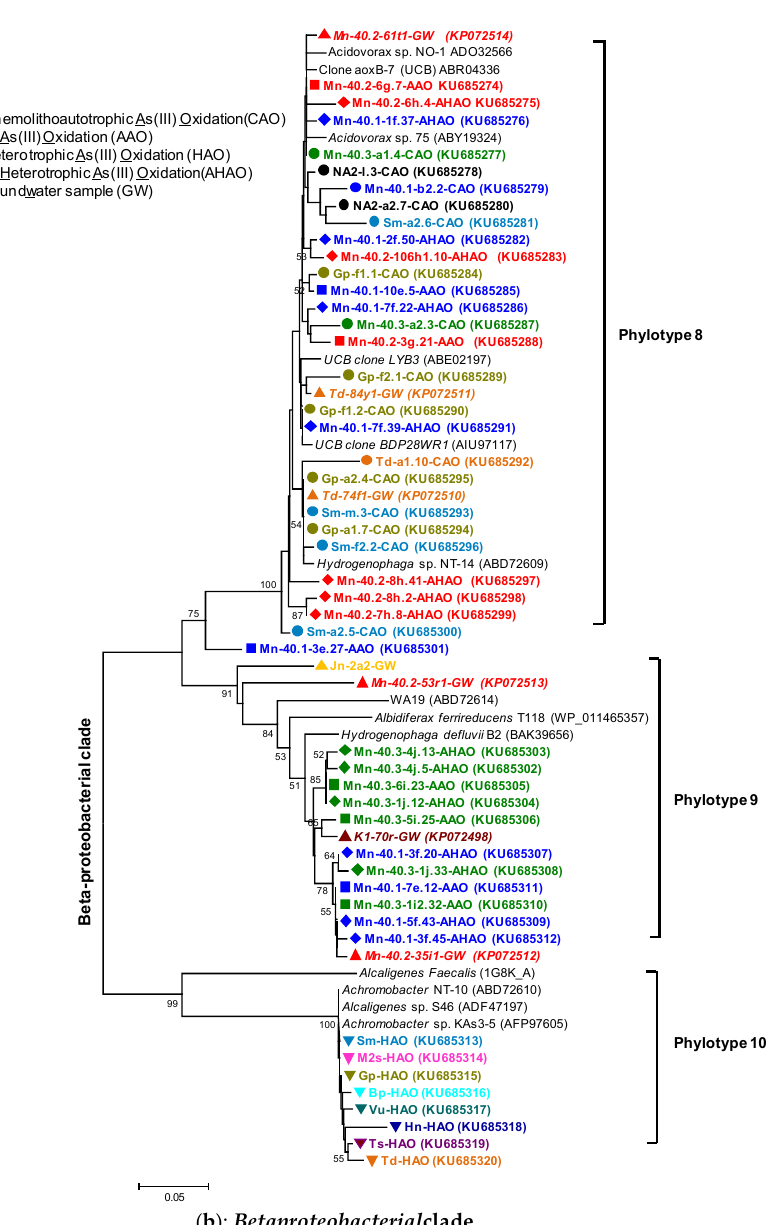
Figure 4. Unrooted neighbor-joining trees of amino acid sequences (160 unambiguously aligned positions) of the ( a ) Alpha - and ( b ) Beta-proteobacterial arsenite oxidase genes retrieved from the selected aerobic, anaerobic and chemolithoautotrophic and heterotrophic enrichments. The trees were constructed with the neighbor-joining method and bootstrap values (1000 replications) are indicated at the interior branches. The scale bar represents 5% sequence divergence. aioA sequences are accompanied by distinct closed symbols for various arsenite-oxidizing enrichments (circles: CAO, squares: AAO: diamonds: AHAO; inverted triangles: HAO) along with the di ff erent colors referring to the various drinking water wells from which the enrichments were initiated. Bold IDs in italics with colored triangles indicate sequences derived directly from groundwater samples, without intermediate culturing [14]. Each clone is represented by the respective enrichment name and an additional number to distinguish between di ff erent RFLP types in the same enrichment. Italics reference aioA sequences [both strains and uncultured bacterium clone (UCB)] available from the GenBank data base (http: // www.ncbi.nlm.nih.gov / Genbank / index.html) and aligned with our previously [14] identified aioA